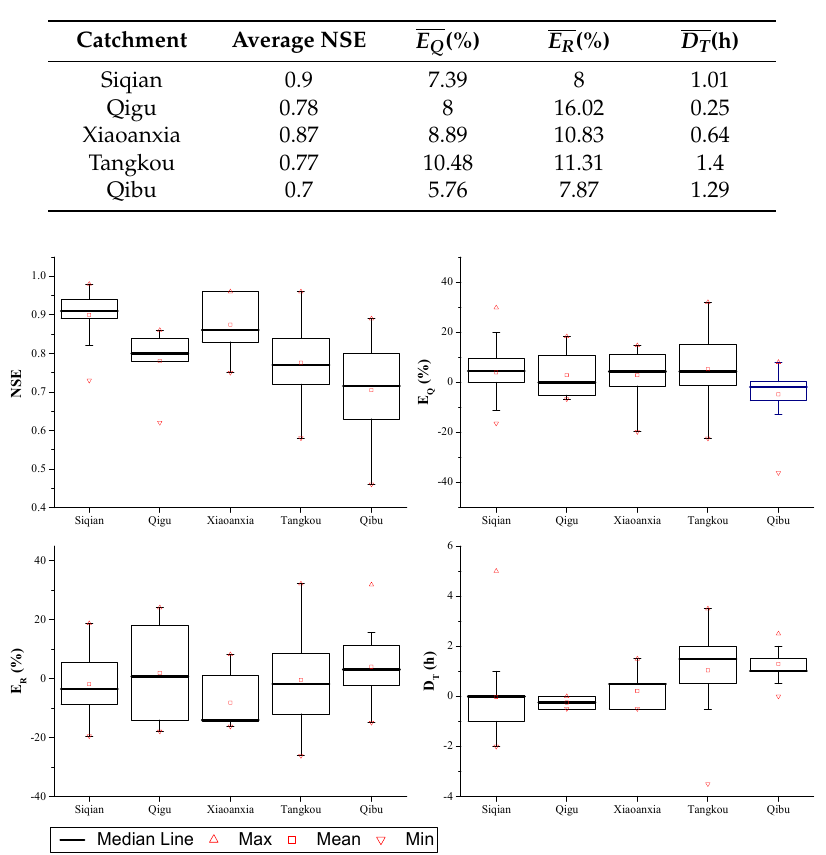
Figure 5. Summary of the performances of the CNFF-HM in five data-rich catchments.